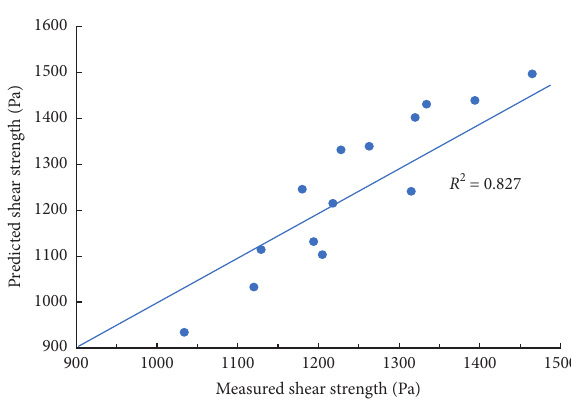
Figure 4: Verification of the prediction